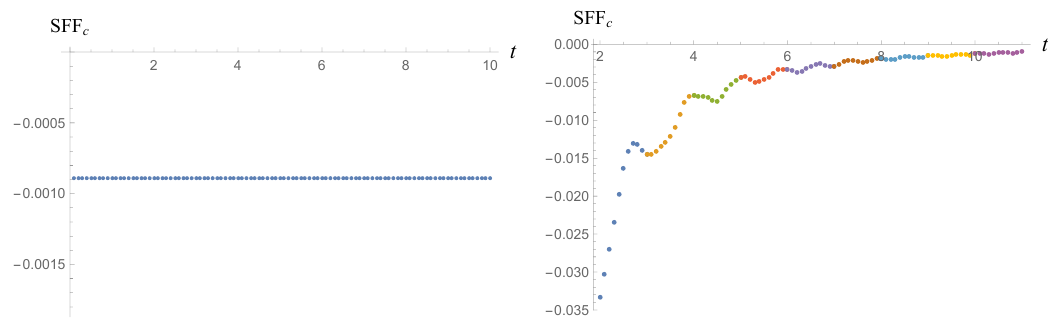
Figure 7 . Left: the connected SFF for (cid:22) = 1 ; (cid:12) = 1 as a function of the time t from the connected wormhole geometry of cylindrical topology. Right: the non-perturbative connected SFF exhibiting a ramp plateau behaviour with persistent oscillations. At late times (around t (cid:24) 10) it approaches approximately the constant value shown in the left (cid:12)gure. Beyond that point the numerical algorithm converges very slowly if we wish to keep the relative error under control.